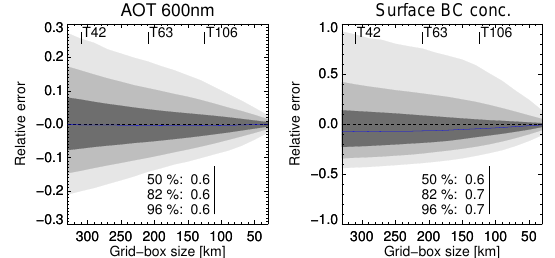
Figure 13. Relative spatial sampling errors (monthly data) as a function of grid-box size. Near the top horizontal axis, standard spectral grid sizes are shown. Near the bottom horizontal axis, the ratios of (cid:49)q 25 ,(cid:49)q 82 and (cid:49)q 96 at two different grid-box sizes (110 and 210km) are given. Results from WRF-Chem MADE over W. Europe. Further explanation in Sect. 3.2.